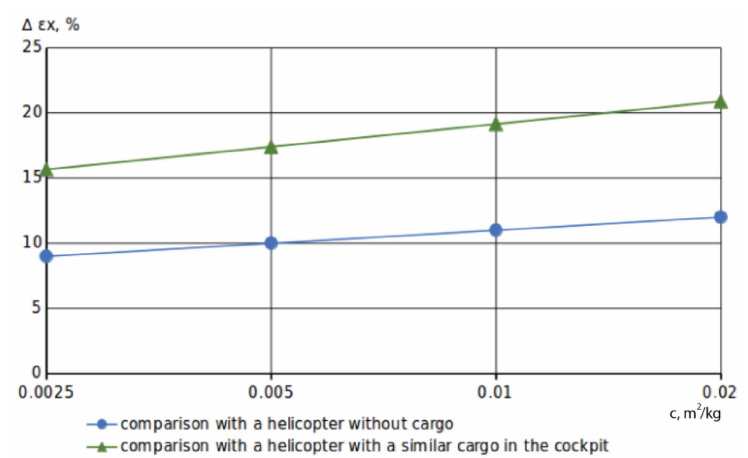
Figure 5. Influence of ballistic coefficient of cargo on the angular acceleration of